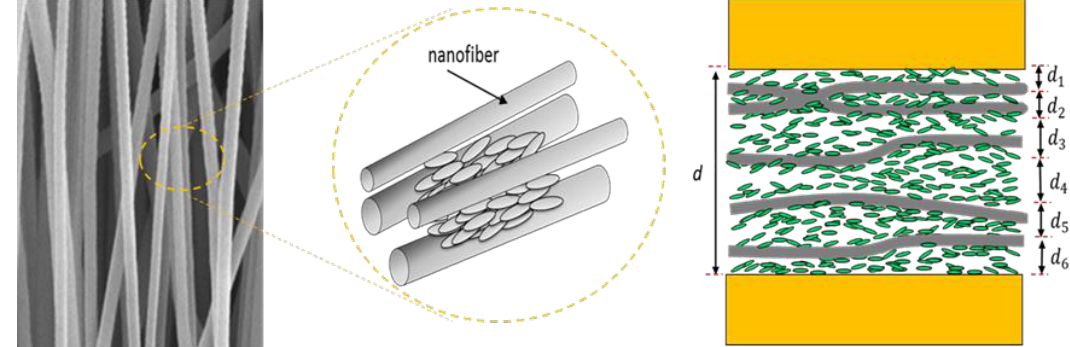
Figure 4. Conceptual diagram of an aligned nanofiber / liquid crystal complex. ( Left ) shows SEM image of aligned nanofiber. ( Center ) and ( Right ) show nanofiber and liquid crystal in the structure of complex and NF / LC cell.